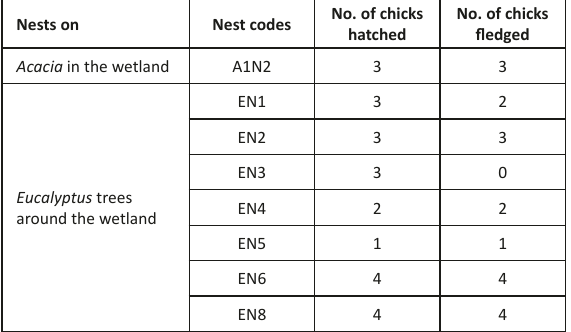
No. of chicks No. of chicks hatched fledged